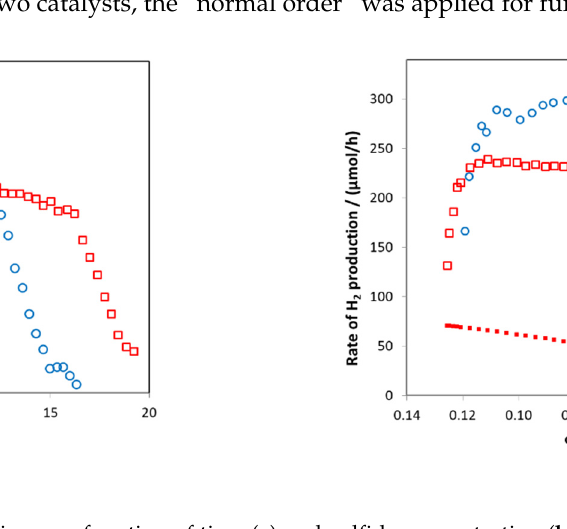
Figure 1. The rate of H 2 production as a function of time ( a ) and sulfide concentration ( b ). The red square and the blue circle symbols represent the rate for catalyst prepared in reverse and normal order, respectively (see in the text). The bars in Figure 1a. shows the average rate calculated for the 200–400 min time region. The small filled squares gives the ratio of sulfide concentration to the total concentration of all sulfur containing anions.